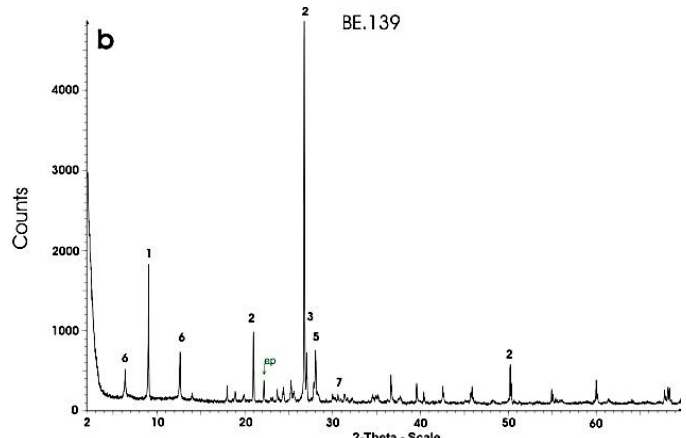
Figure 7. Representative X-ray diffraction patterns of the studied intermediate-acidic rock samples: ( a ) dacite and ( b ) granodiorite. Sample numbers are indicated as insets (1: mica, 2: quartz, 3: K-feldspars, 4: cristobalite, 5: plagioclase, 6: chlorite, 7: epidote).